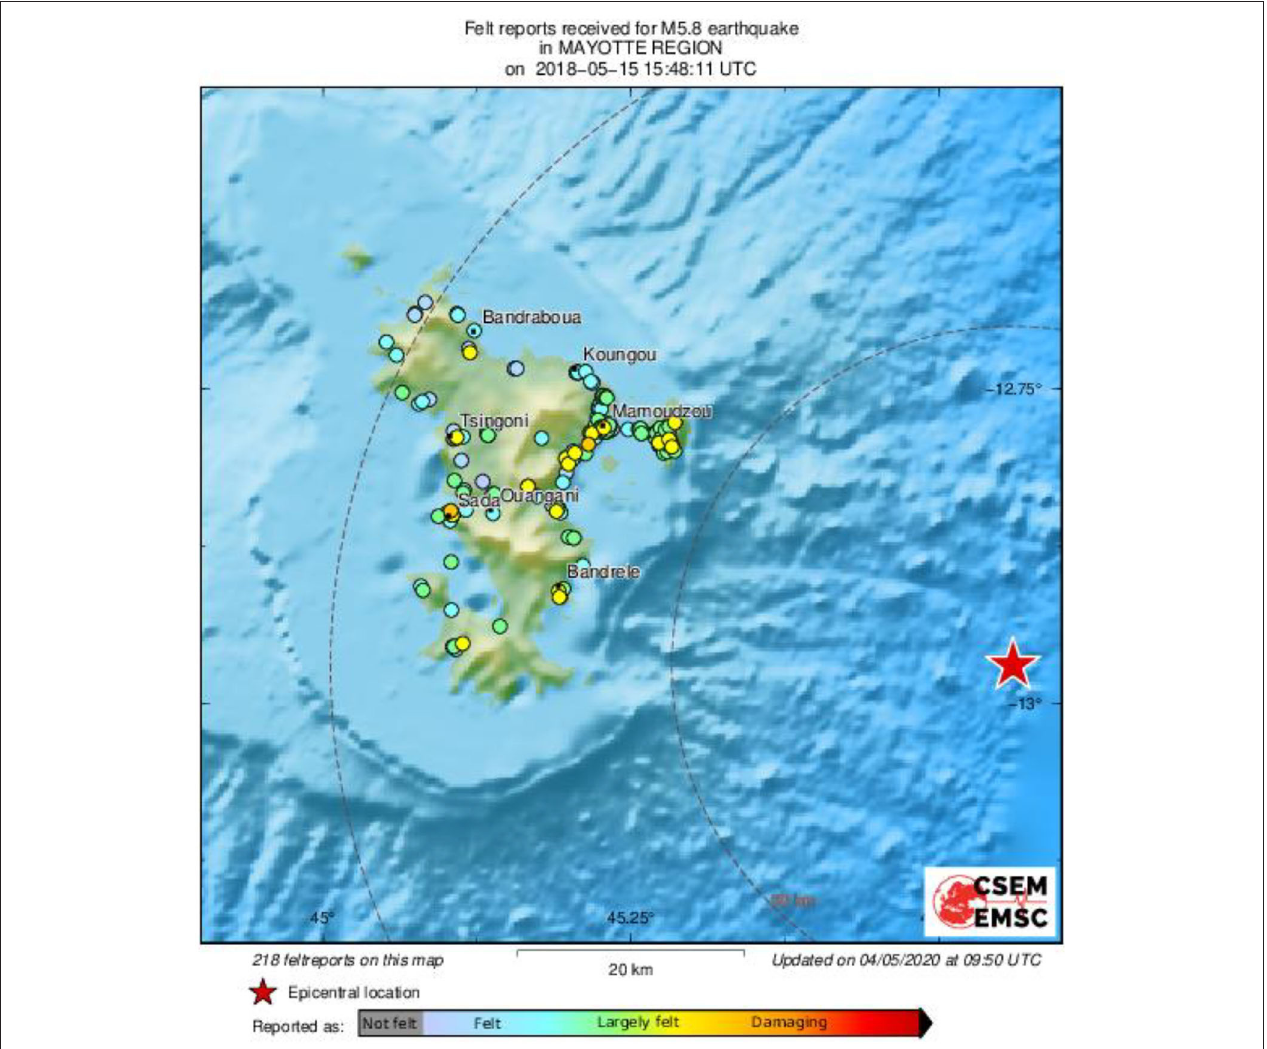
FIGURE 3 | Felt map for the M5.8 earthquake (2018-05-21). Each dot represents a felt report collected by EMSC, color corresponds to the felt shaking intensity reported by